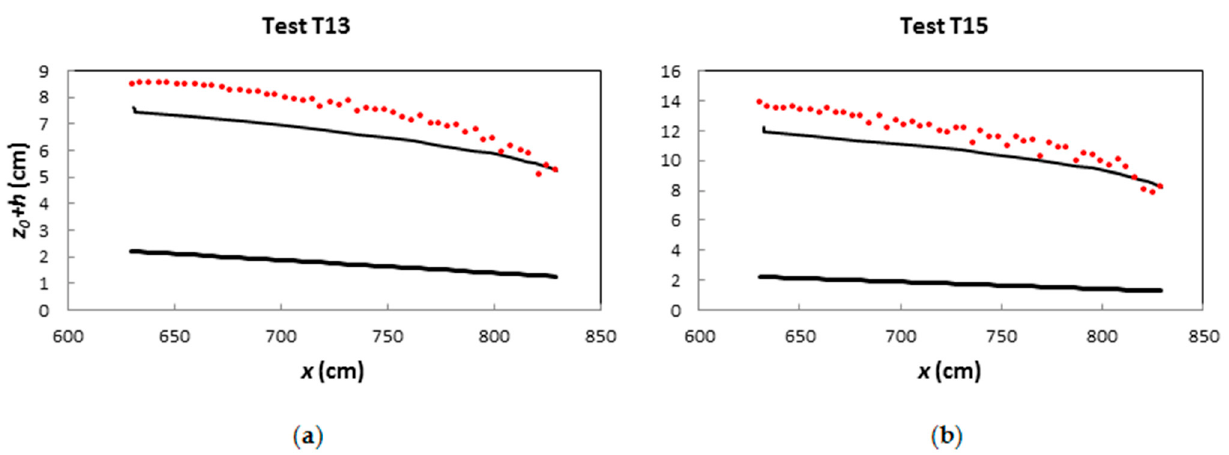
Figure 12. Comparison between the measured and the calculated free surface profiles obtained using C D − UC in the case of staggered pattern: ( a ) T13; ( b ) T15. The black bold line indicates the flume bottom; the black line is the calculated free surface; the red symbols indicate the measured free